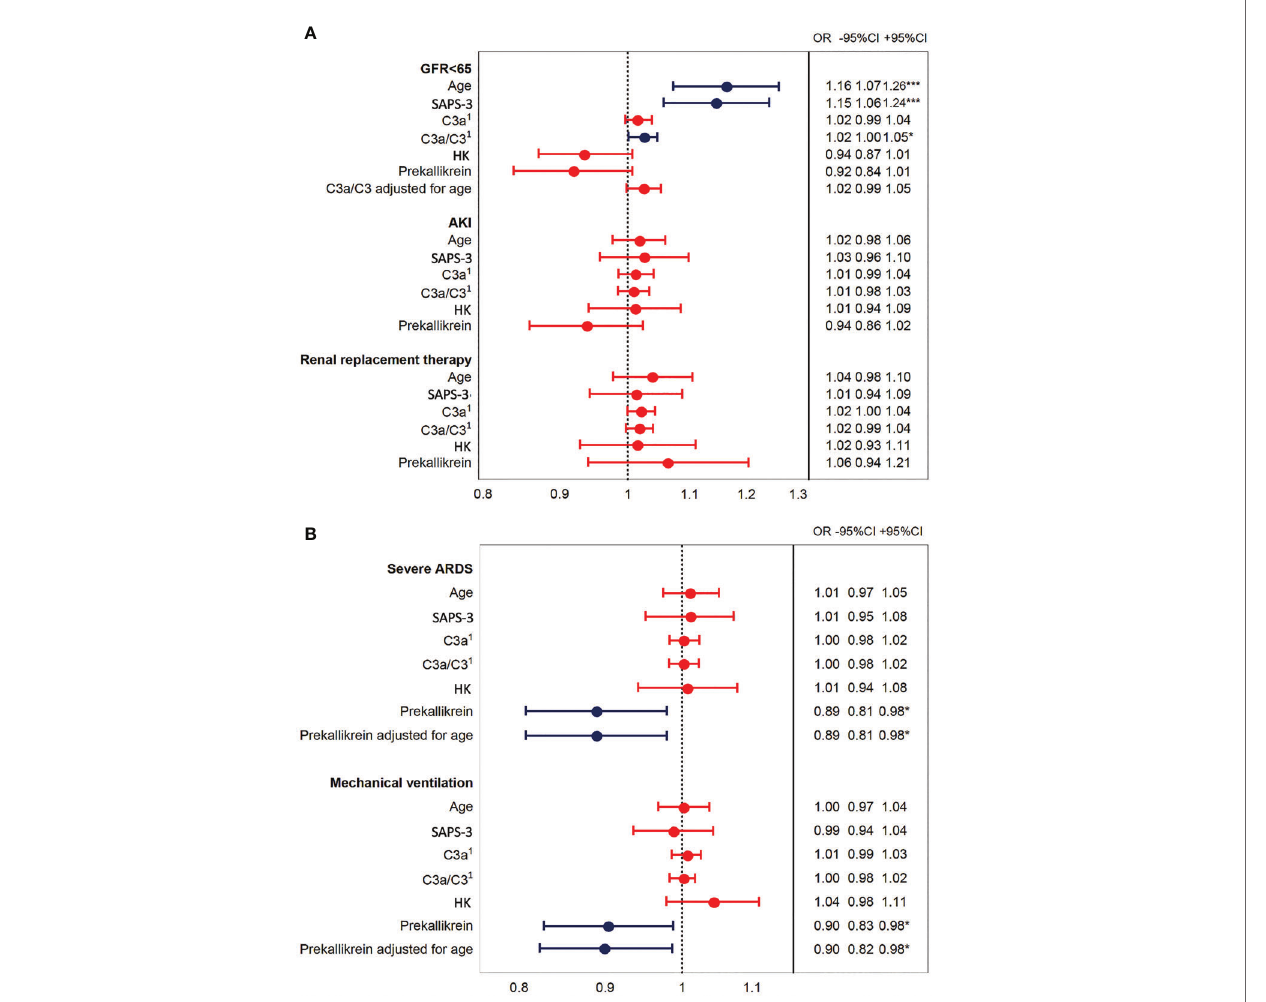
FIGURE 5 | Association of IIIS activation in COVID-19 ARDS with organ damage. The plot shows odds ratios for IIIS activation variables C3a, C3a/C3, HK, and prekallikrein levels that were associated with death in Figure 4 . Age is included as a surrogate for the pre COVID-19 risk of death and SAPS-3 as a marker of illness severity. Panel (A) depicts the kidney failure related outcomes, low glomerular fi ltration rate (GFR < 65 ml/min), acute kidney injury (AKI, vs. no AKI), and renal replacement therapy, i.e., dialysis. Panel (B) depicts the respiration failure related outcomes severe acute respiratory distress syndrome (ARDS, vs. mild or moderate ARDS) and mechanical ventilation. Blue intervals indicate statistical signi fi cance (*, *** right hand table), while red intervals do not. Increasing C3a/C3 ratios were predictors of low GFR but not after adjustment for age, while decreased prekallikrein levels were associated with respiratory failure also after adjustment for